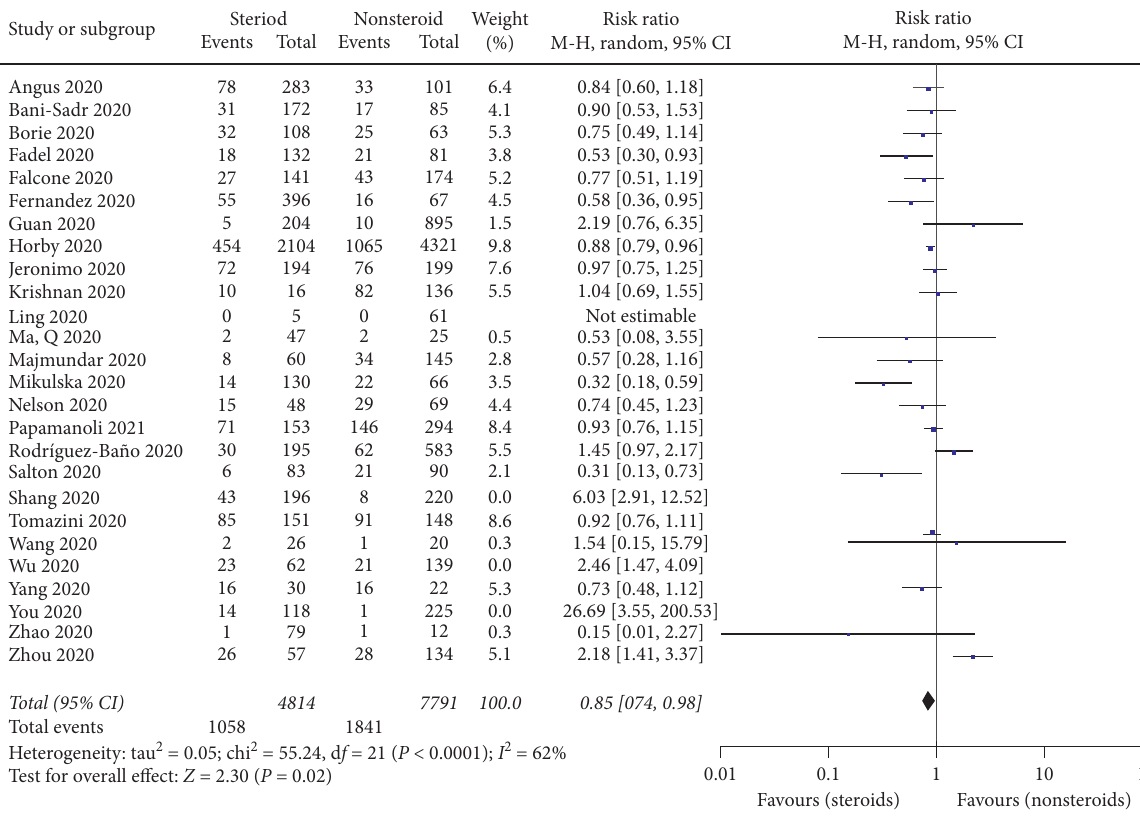
Figure 7: Sensitivity analysis: forest plot for mortality of COVID-19 patients taking steroids versus